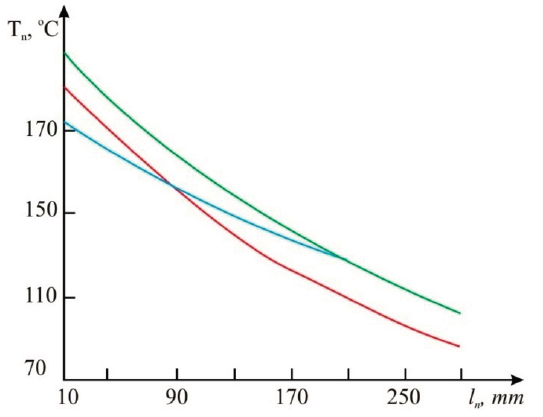
Figure 10. The graphs of dependence Т n on l н ( d тр =15 mm; d н =3 mm): gasoline; diesel fuel; biofuels, the thermocouple error is 5 ° С